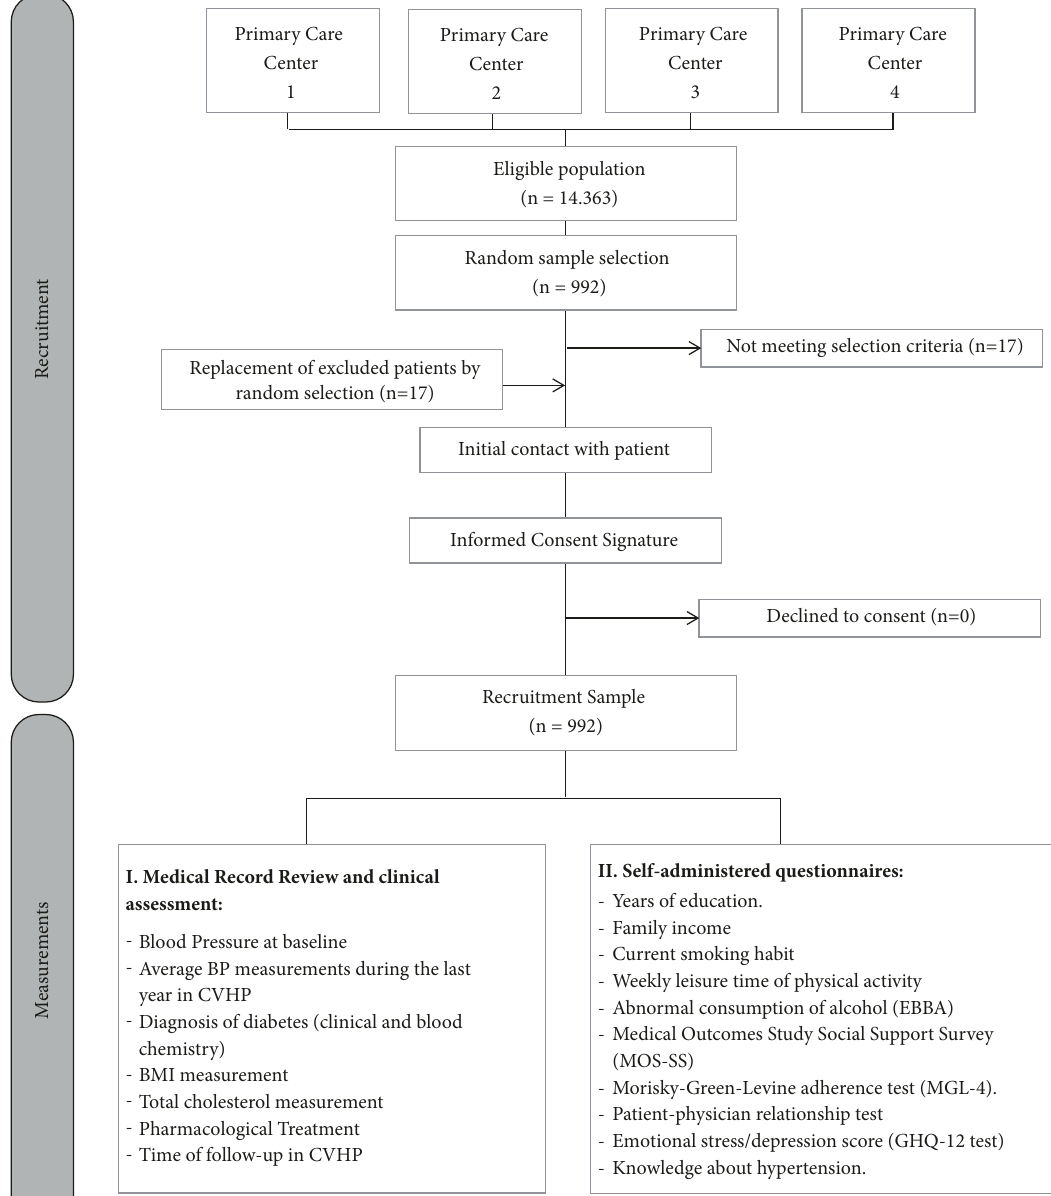
Figure 1: Recruitment process and procedures followed after patient’s agreement to participate in the study.